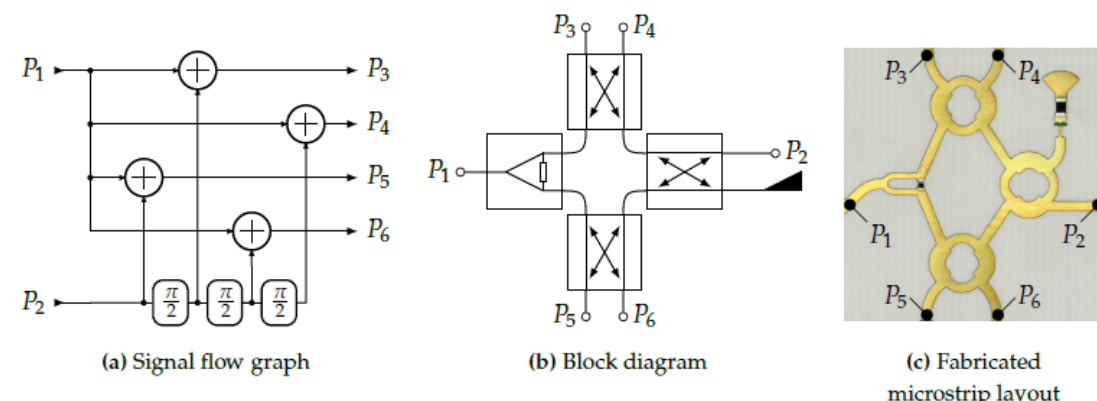
Figure 4. A flowchart showing the overall signal processing